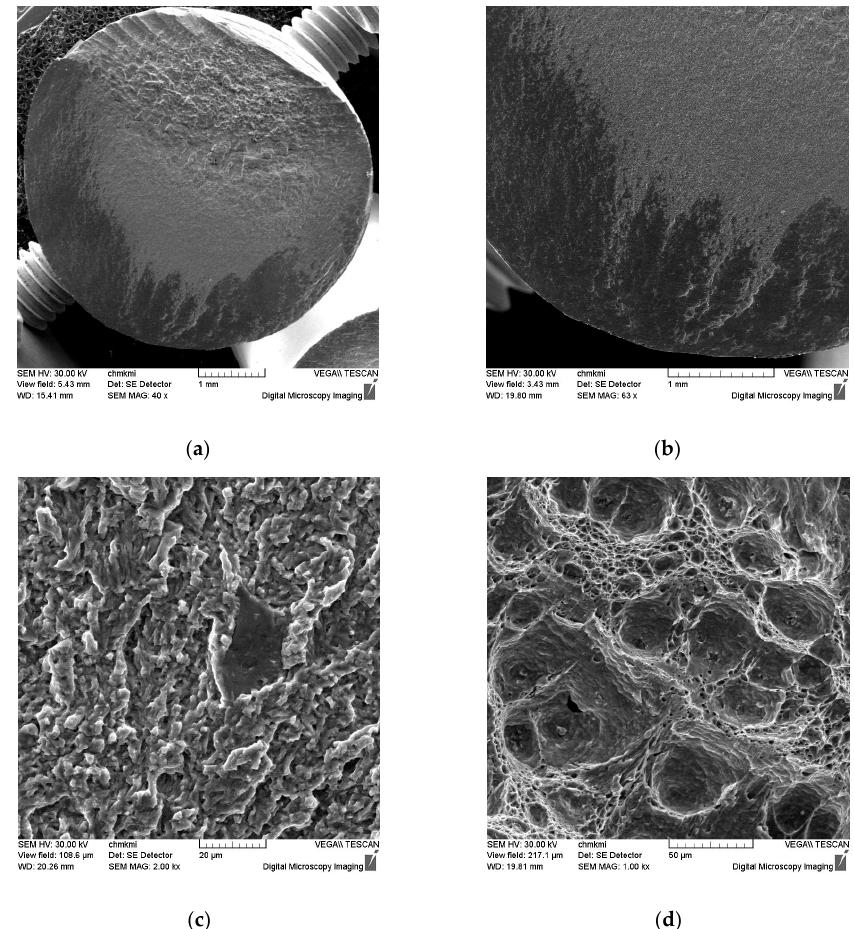
Figure 12. Fracture surface of as-welded Strenx 700 MC specimen loaded at 395 MPa and fractured after 6.86 × 10 5 cycles: Overall view of the fracture ( a ), detail of surface fatigue crack initiation ( b ), fatigue crack propagation with intercrystalline facet ( c ) and final fracture ( d ).